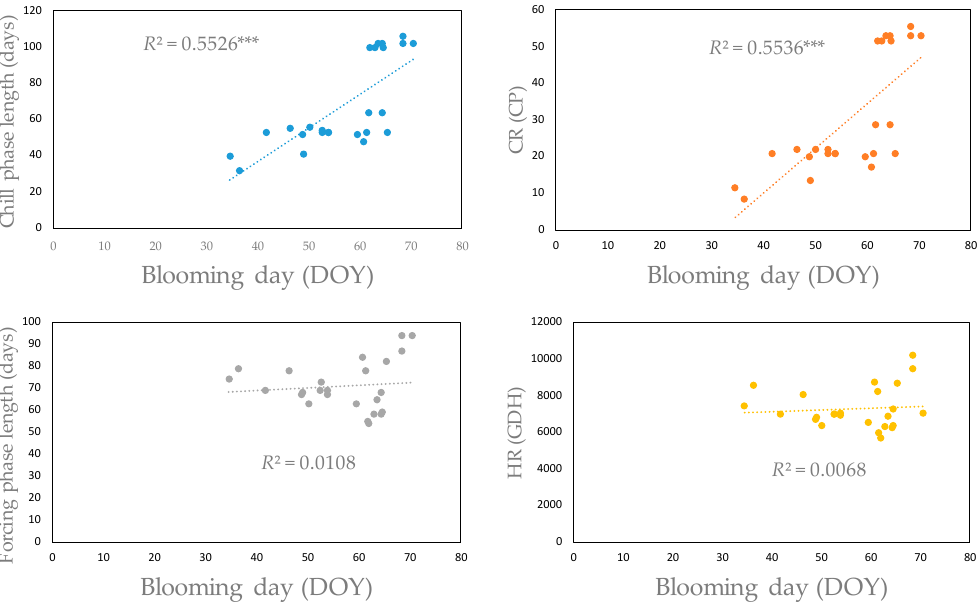
Figure 6. Correlations between almond cultivar blooming day and chill phase length (up, left), CR (up, right), forcing phase length (bottom, left) and HR length Almond and apple cultivars. DOY, day of year. *** Statistically significant p < 0.001.